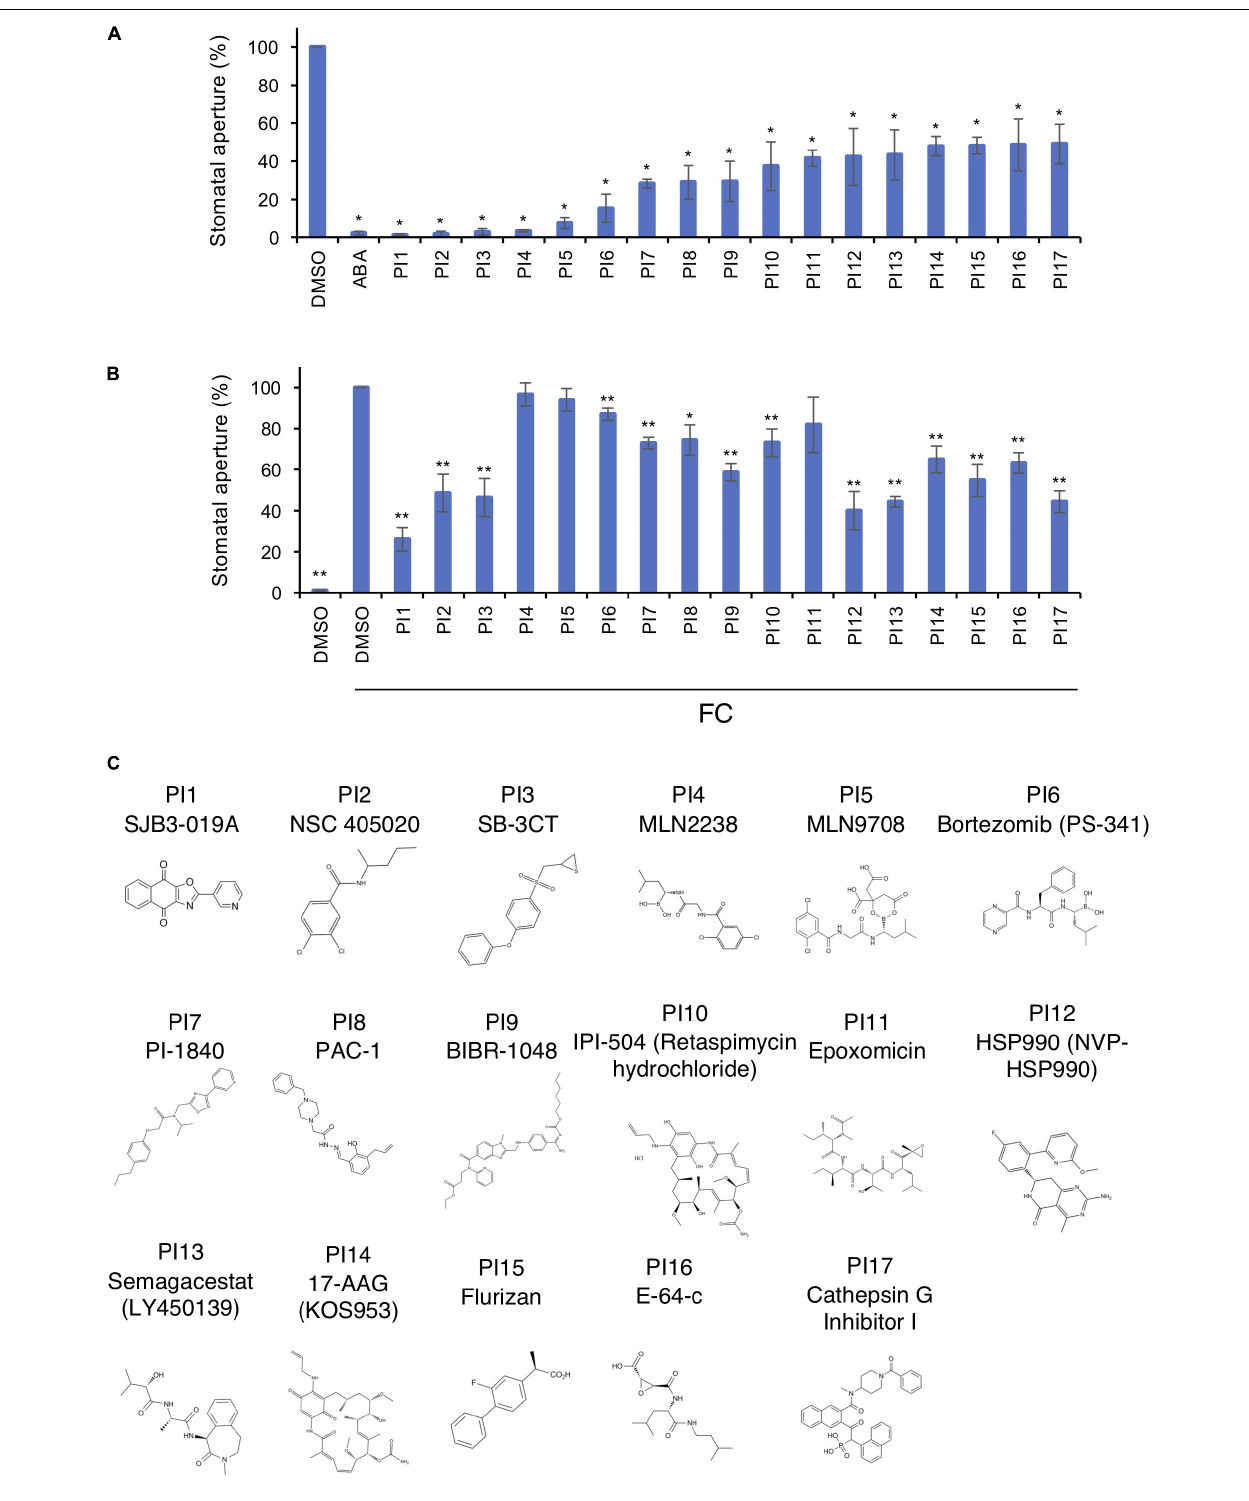
FIGURE 1 | Inhibition of light- and FC-induced stomatal opening by proteinase inhibitors (PIs). (A) Inhibition by PIs of light-induced stomatal opening. Leaf discs were pre-treated with compounds for 30 min in the dark and illuminated with light (150 µ mol m − 2 s − 1 red light and 50 µ mol m − 2 s − 1 BL) for 3 h. ABA, 10 µ M; PIs, 100 µ M. Means ± SE ( n = 5, 30 stomata per 2 leaf discs per repeat). Student’s t -test, * P < 0.01. (B) Suppression by PIs of FC-induced stomatal opening. Leaf discs were incubated with PIs in basal buffer for 30 min, FC was added, and incubated for 3 h in the dark. PIs, 100 µ M; FC, 10 µ M. Means ± SE ( n = 4, > 50 stomata from 3 leaf discs per repeat). Student’s t -test, * P < 0.05, ** P < 0.01. (C) Chemical structures of PIs.